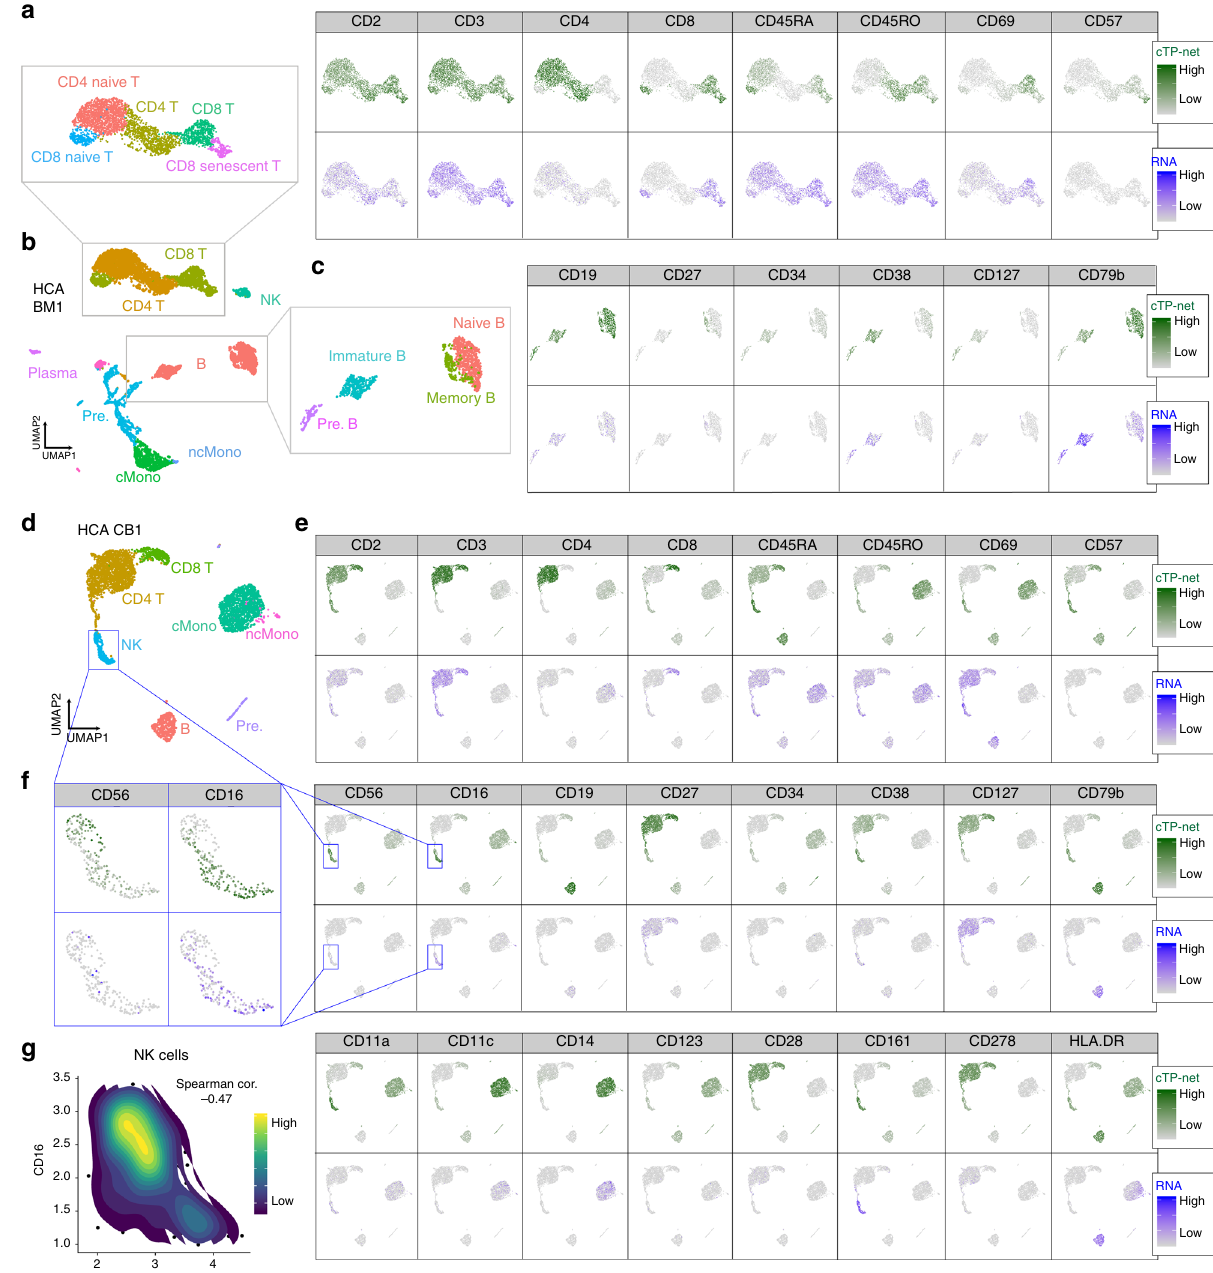
Fig. 3 Imputation results analysis on Human Cell Atlas data sets. a Left panel: UMAP visualization of MantonBM1 BMMCs T cell subpopulation based on RNA expression, colored by cell type. CD4 T: mature CD4 + T cells; mature CD8 T: CD8 + T cells; naïve CD4 T: naïve CD4 + T cells; naïve CD8 T: naïve CD8 + T cells; CD8 senescent T: CD8 + senescent T cells. Right panel: Related imputed protein abundance and RNA expression of its corresponding gene. b UMAP visualization of MantonBM1 BMMCs based on RNA expression, colored by cell type. B: B cells; CD4 T: CD4 + T cells; CD8 T: CD8 + T cells; cMono: classical monocyte; ncMono: non-classical monocyte; NK: natural killer cells; Pre.: precursors; Plasma: plasma cells. c Left panel: UMAP visualization of MantonBM1 BMMCs B cell subpopulation based on RNA expression, colored by cell type. Pre.B: B cell precursors; immature B: immature B cells; memory B: memory B cells; naïve B: naïve B cells. Right panel: Related imputed protein abundance and RNA expression of its corresponding gene. d UMAP visualization of MantonCB1 CBMCs based on RNA expression, colored by cell type. e cTP-net imputed protein abundance and RNA read count of its corresponding gene for 24 surface proteins. f UMAP visualization of MantonCB1 CBMCs NK cell subpopulation colored by CD56 and CD16 imputed protein abundance and RNA read count. Reverse gradient is observed in cTP-net prediction but not in the read count for its corresponding RNA. g Contour plot of cells based on imputed CD56 and CD16 abundance in NK cell populations. Strong negative correlation (Spearman correlation = − 0.47) with two subpopulation